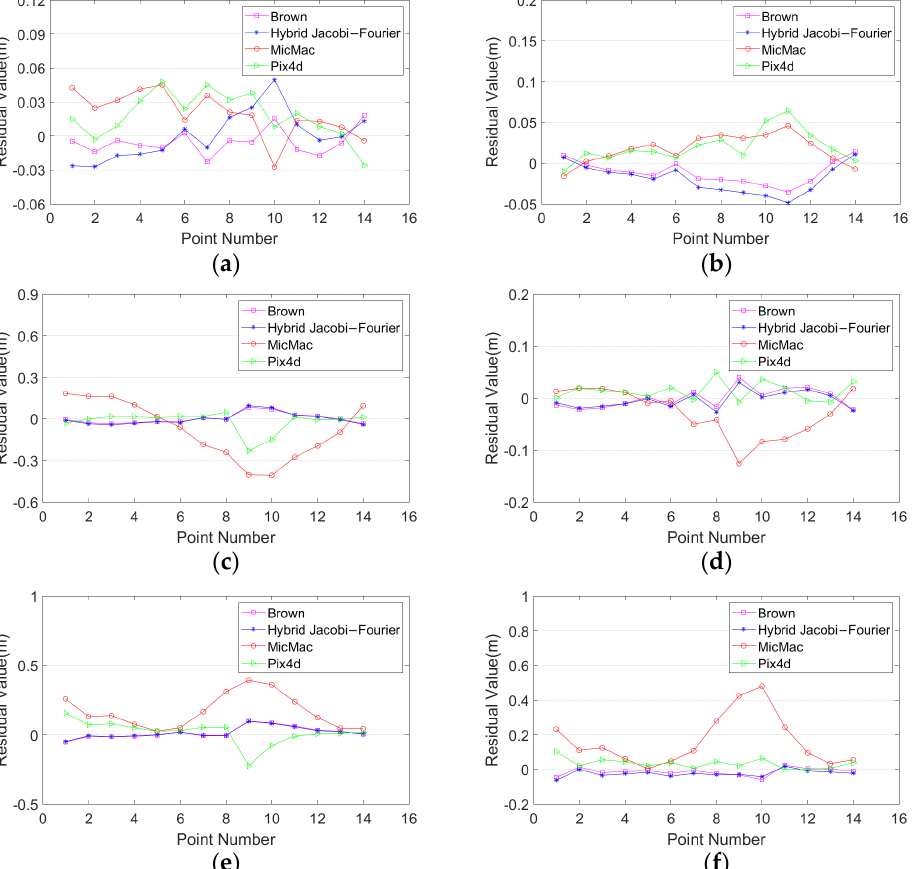
Figure 13. The residuals of check points after self-calibration with one single GCP for test site 1. ( a , c , e ) The residuals of check points of rectangle dataset in the direction of X, Y, and Z, respectively; ( b , d , f ) the residuals of check points of S-shaped dataset in the direction of X, Y, and Z, respectively.